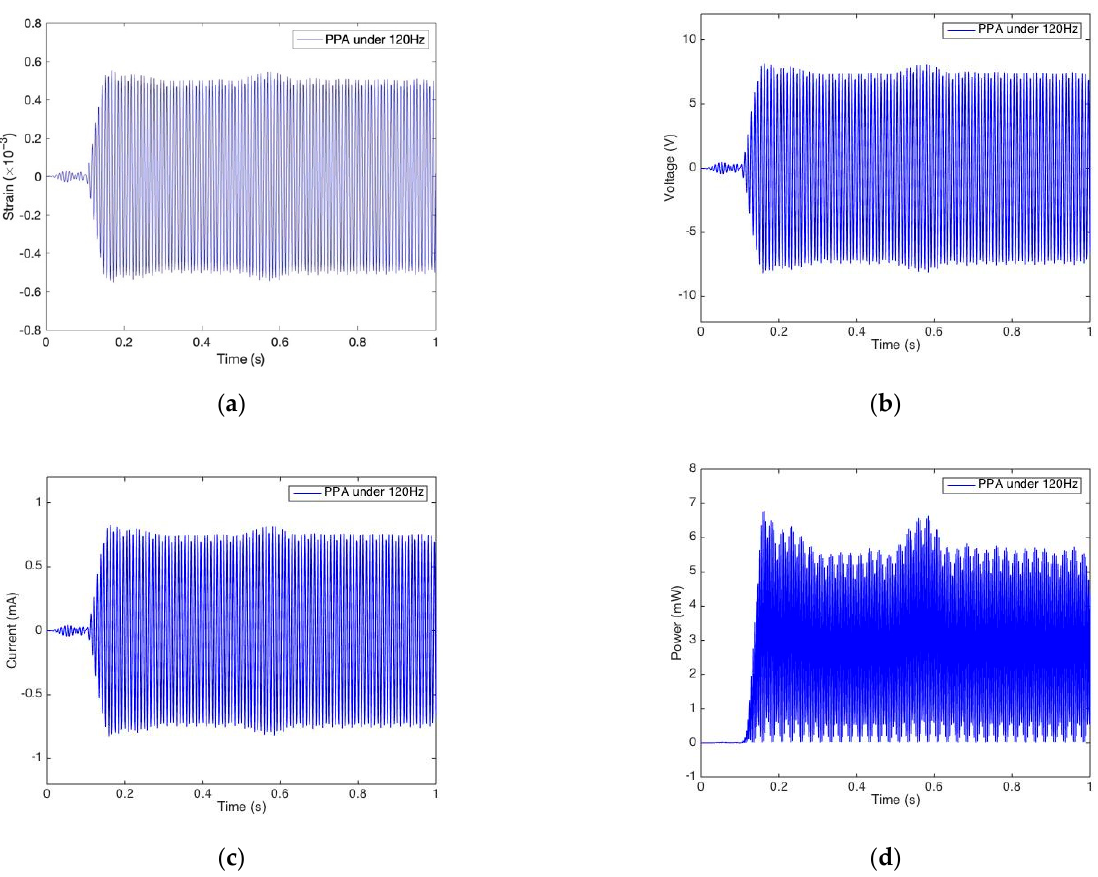
Figure 6. Mechanical and electric responses from PPA under resonant excitation. ( a ) Strain response for PPA under 120 Hz; ( b ) Voltage response for PPA under 120 Hz; ( c ) Current response for PPA under 120 Hz; ( d ) Power response for PPA under 120 Hz.